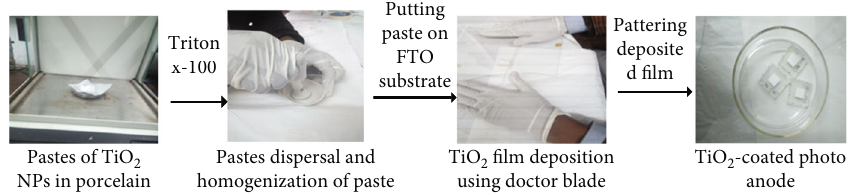
Figure 2: Flow charts for preparation of titanium oxide paste and its deposition as photoanode fi lms on FTO glass substrate.